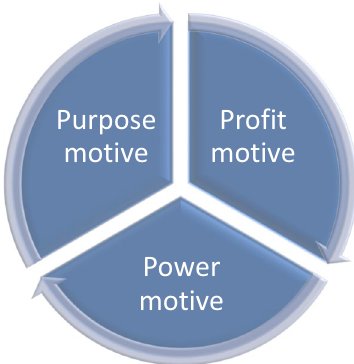
Fig. 1 Motivations driving AI creation and